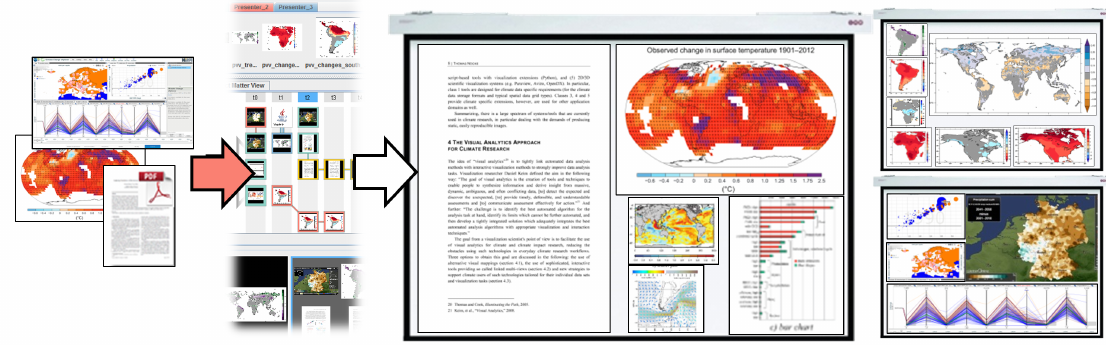
Figure 7. Persons from the audience provide additional information by integrating articles, maps and other generated views. In this way, they can share information with other persons and contribute to a